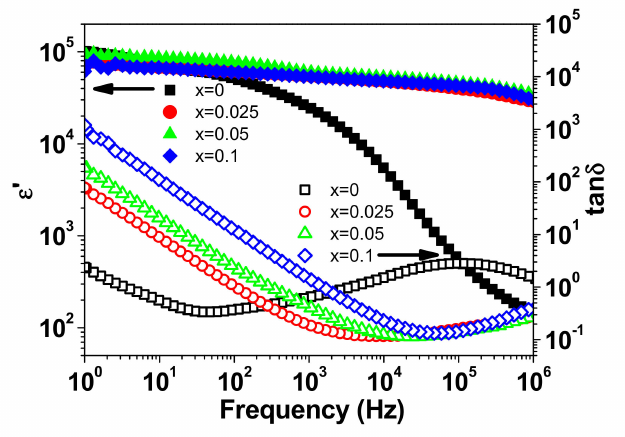
Figure 4. Frequency dependence of ε (cid:48) and tan δ at room temperature for NSTO